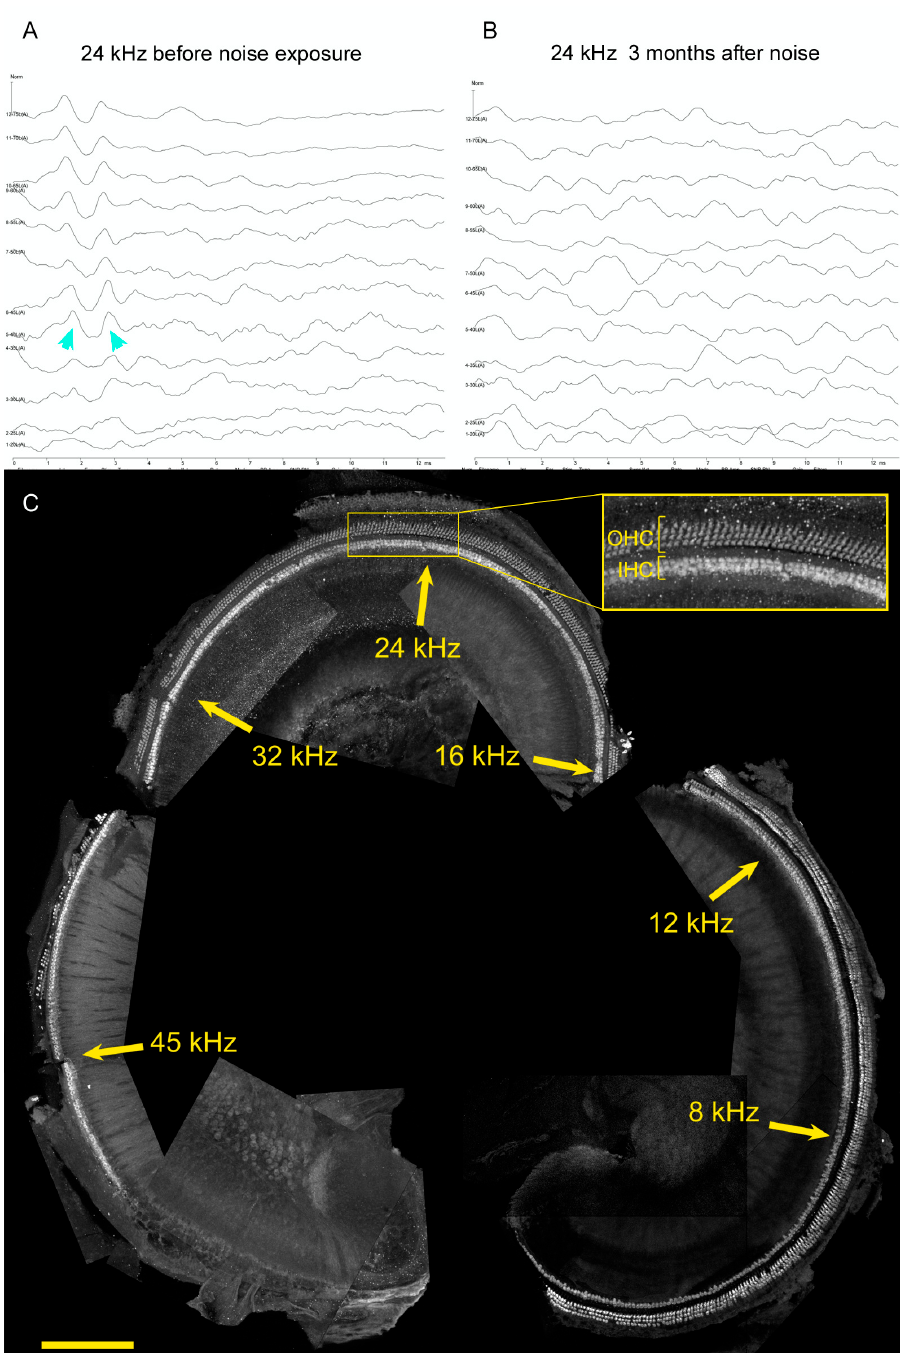
Figure 3. Hearing loss from noise does not require HC loss. ( A , B ) ABR to 24 kHz stimuli presented at 5 dB intervals, starting at 75 dB (top trace) and ending at 20 dB. Results from a test administered to a naïve mouse at 1 month of age ( A ) are compared to the same mouse three months after traumatic noise exposure ( B ). Cyan arrowheads indicate the threshold trace in ( A ); no waveforms are seen after traumatic noise. ( C ) Cochlea surface preparation from the same mouse euthanized after the testing shown in ( B ). Anti-MYO7 and anti-OCM immunostaining are both shown in white to reveal IHCs and OHCs. Approximate frequencies are indicated in yellow. The inset shows a high-power image of the region of interest, with OHC and IHC populations indicated. Size bar: 200 microns. Methods are from